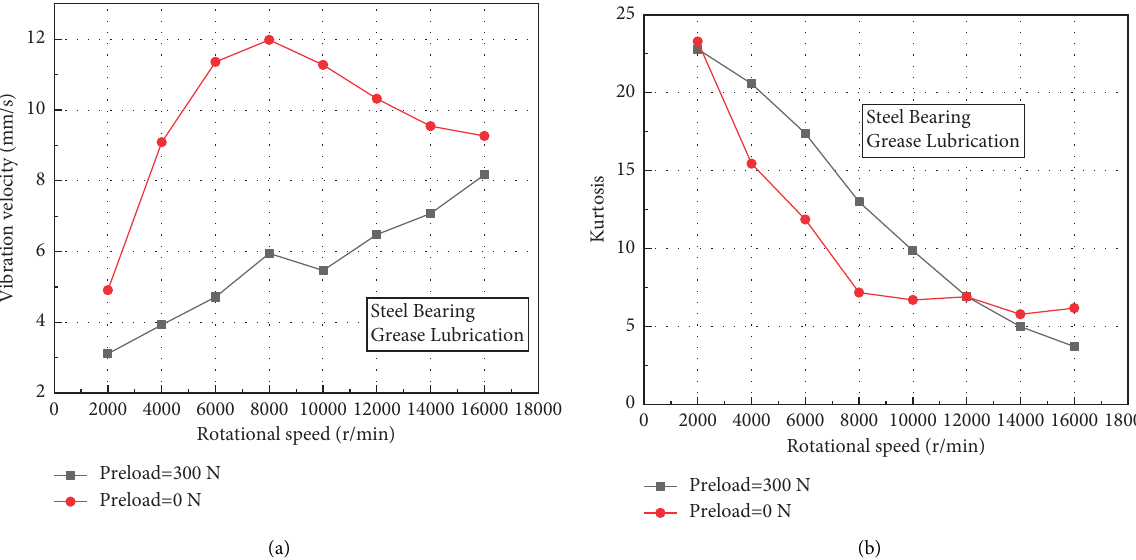
Figure 8: Variation of vibration velocity and kurtosis for steel bearings under grease lubrication condition. (a) Variation velocity. (b) Kurtosis.